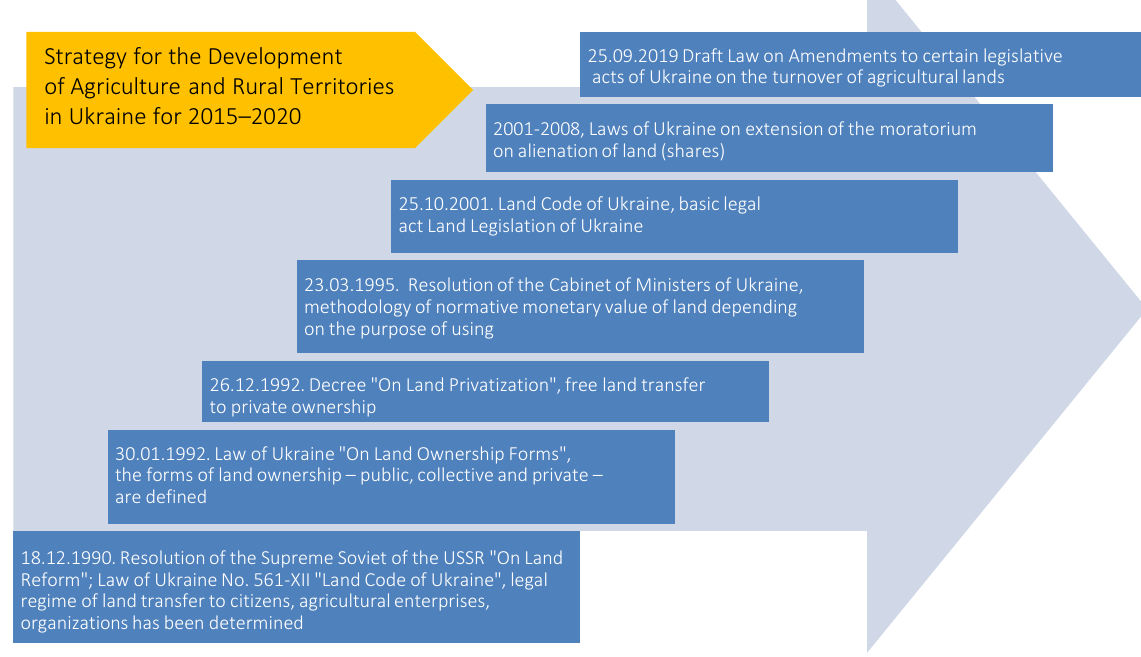
Figure 2. Legislative acts on implementation of land reform in